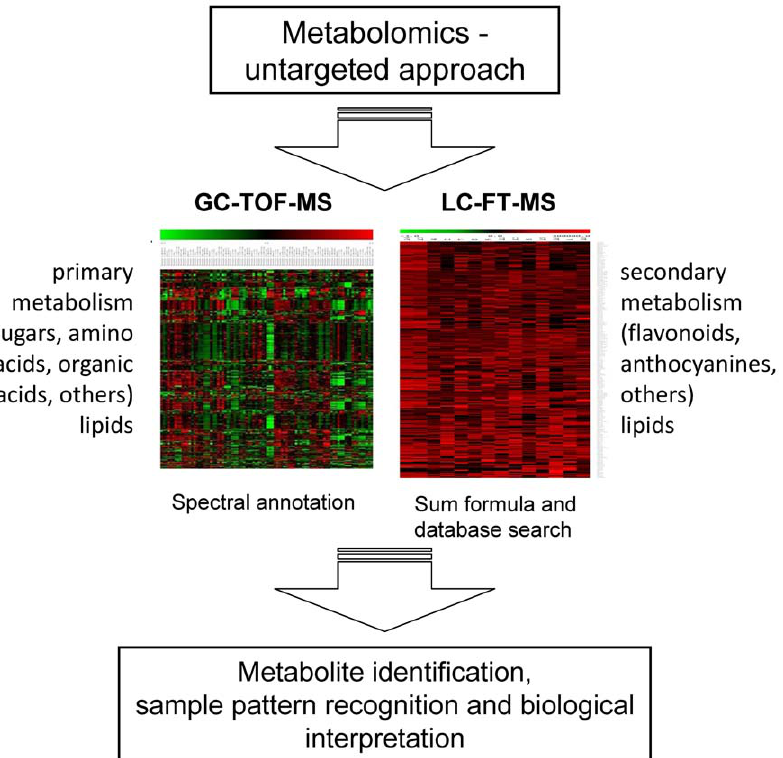
Figure 1. Schematic view on the techniques used to gain metabolomic coverage. A combination of GC-TOF-MS and LC-FT-MS leads to high metabolome coverage providing the basis for completely unbiased analysis (see text for more details).